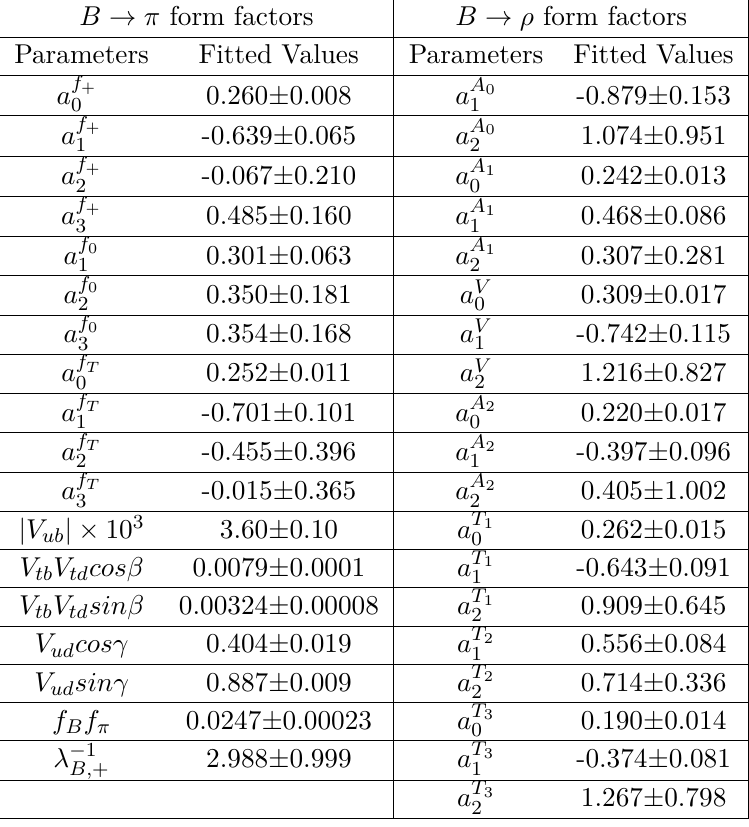
Table 5 . Fit results using all the available